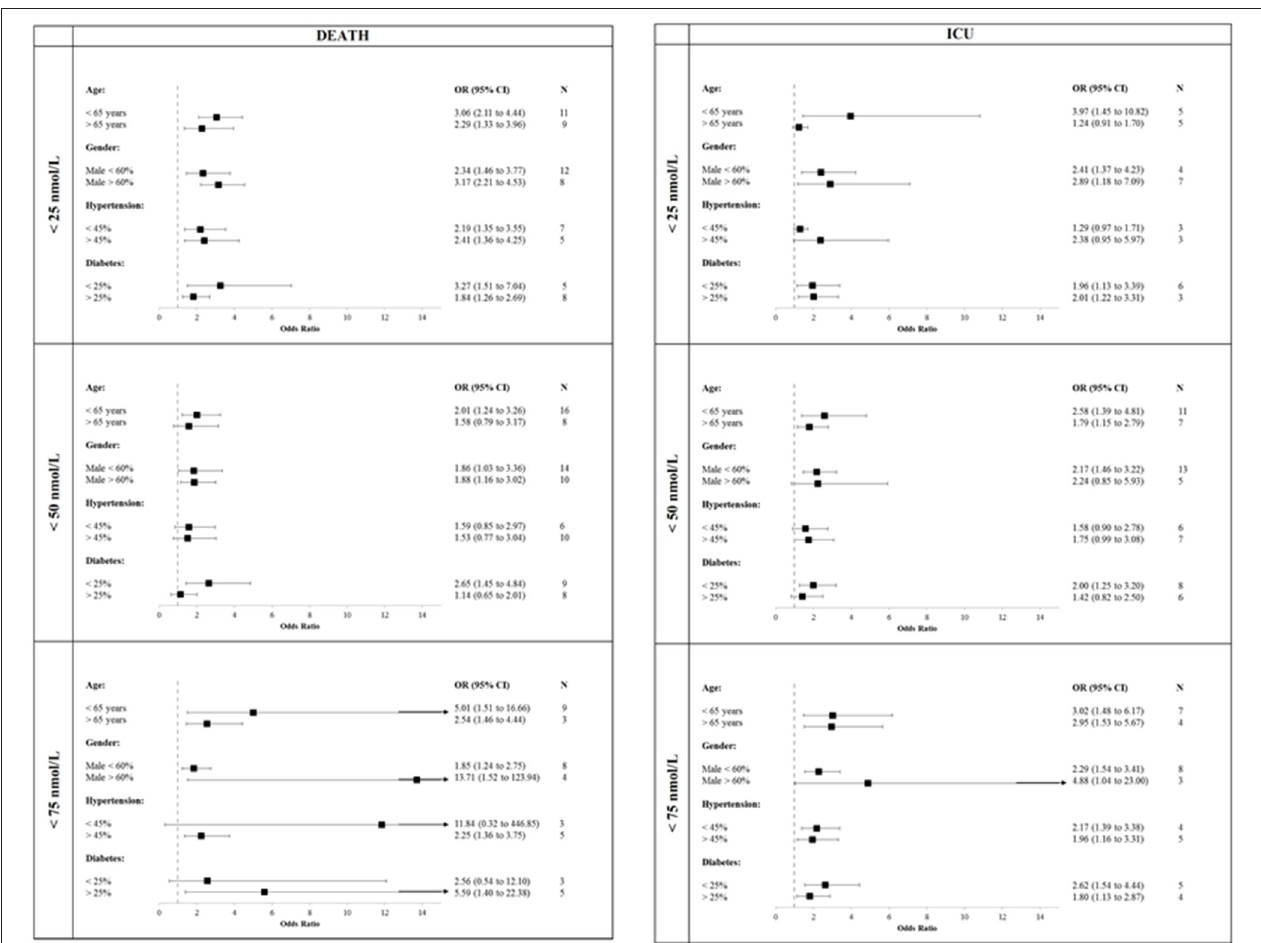
FIGURE 4 | Studies stratified in categories of age, prevalence of males, hypertension and diabetes. COVID-19, Coronavirus Disease-2019; ICU, intensive Care Unit; < 25 nmol/L, 25OHD levels below 25 nmol/L; < 50 nmol/L, 25OHD levels below 50 nmol/L; < 75 nmol/L, 25OHD levels below 75 nmol/L.